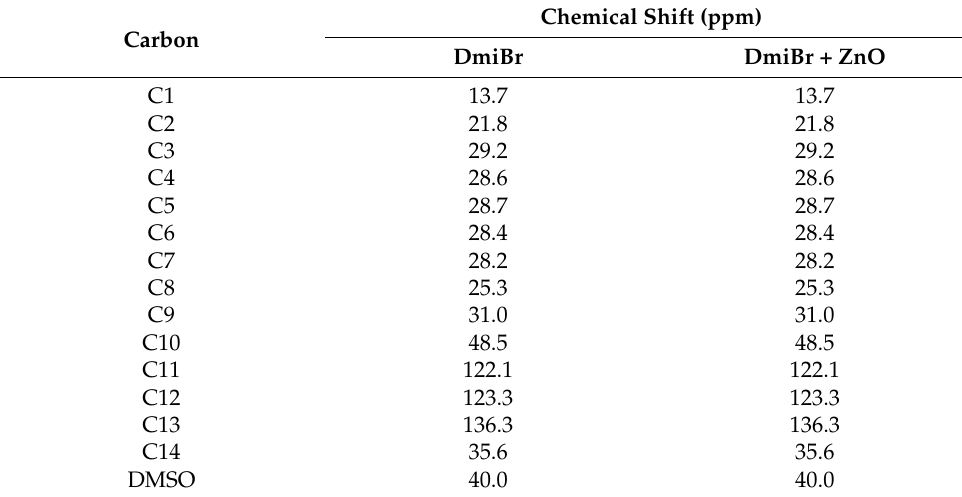
Table 6. 13 C NMR chemical shifts for pure DmiBr and its mixture with ZnO (1:1). Carbon